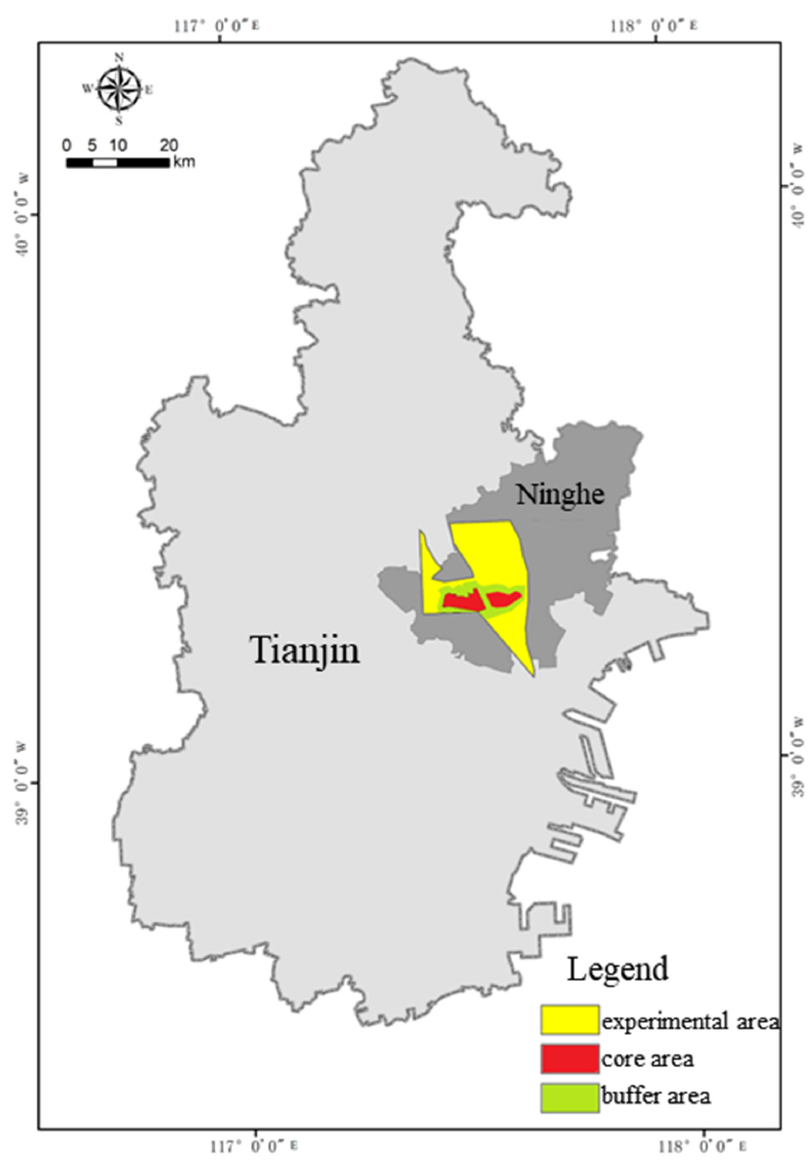
Figure 2. Geographic location map of Qilihai Wetland.